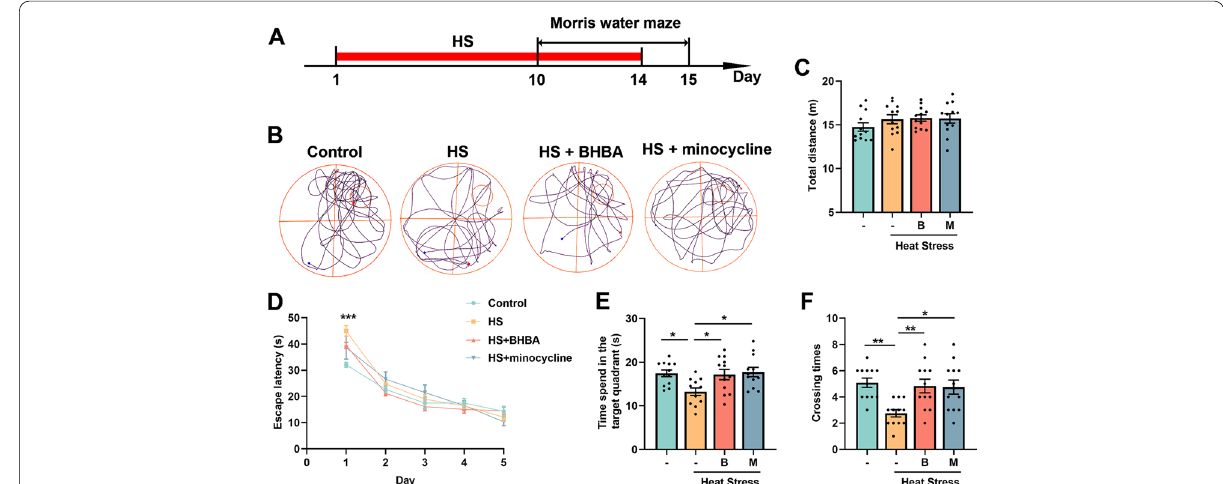
Fig. 1 BHBA ameliorates spatial memory impairments in the heat stress-treated mice. A Experimental procedure of MWM. B Representative trajectories at day 6 of MWM. C Total swimming distance in the MWM. D Escape latency during the acquisition test (day 1–5). E – F Time spent in the target quadrant ( E ) and the number of platform crossings ( F ) in the prob trail on day 6. Both parameters decreased significantly in the heat-exposed mice and increased after treatment with BHBA or minocycline. For acquisition training (days 1 to 5) of the MWM, data was analyzed using a two-way ANOVA followed by a Tukey’s post-test to analyze the difference in escape latency between each group. Other data analyses were performed using one-way ANOVA with Tukey’s post-test. Data are represented as mean SEM. C - F n 12. *, control vs heat stress. * p < 0.05, ** p < 0.01, *** p < 0.001. B, ± = BHBA; HS, heat stress; M,